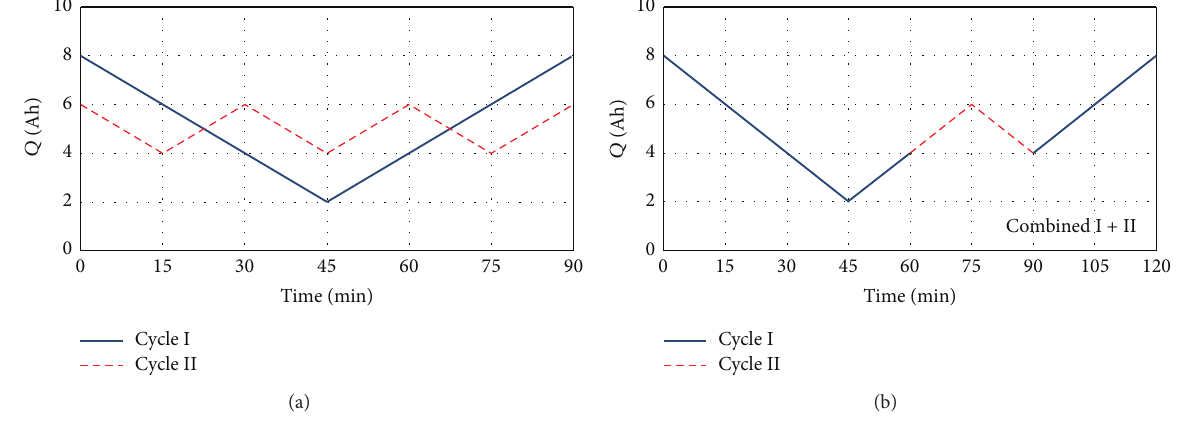
Figure 1: (a) Elemental test cycles and (b) combination of the two elemental cycles. Table 1: Main data of the cells under